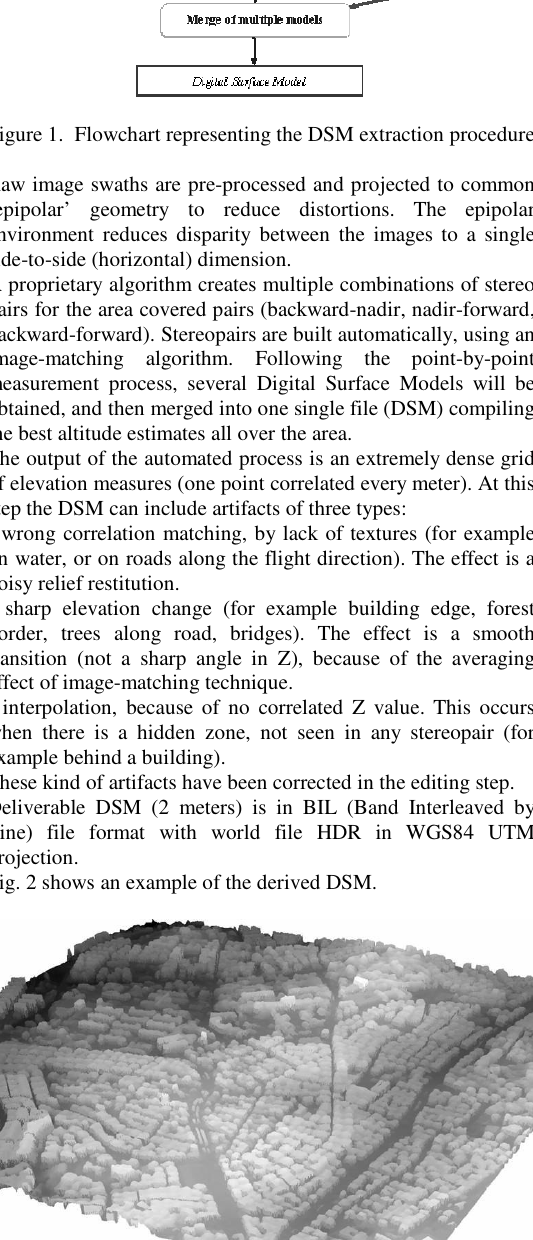
Figure 2. Example of the derived